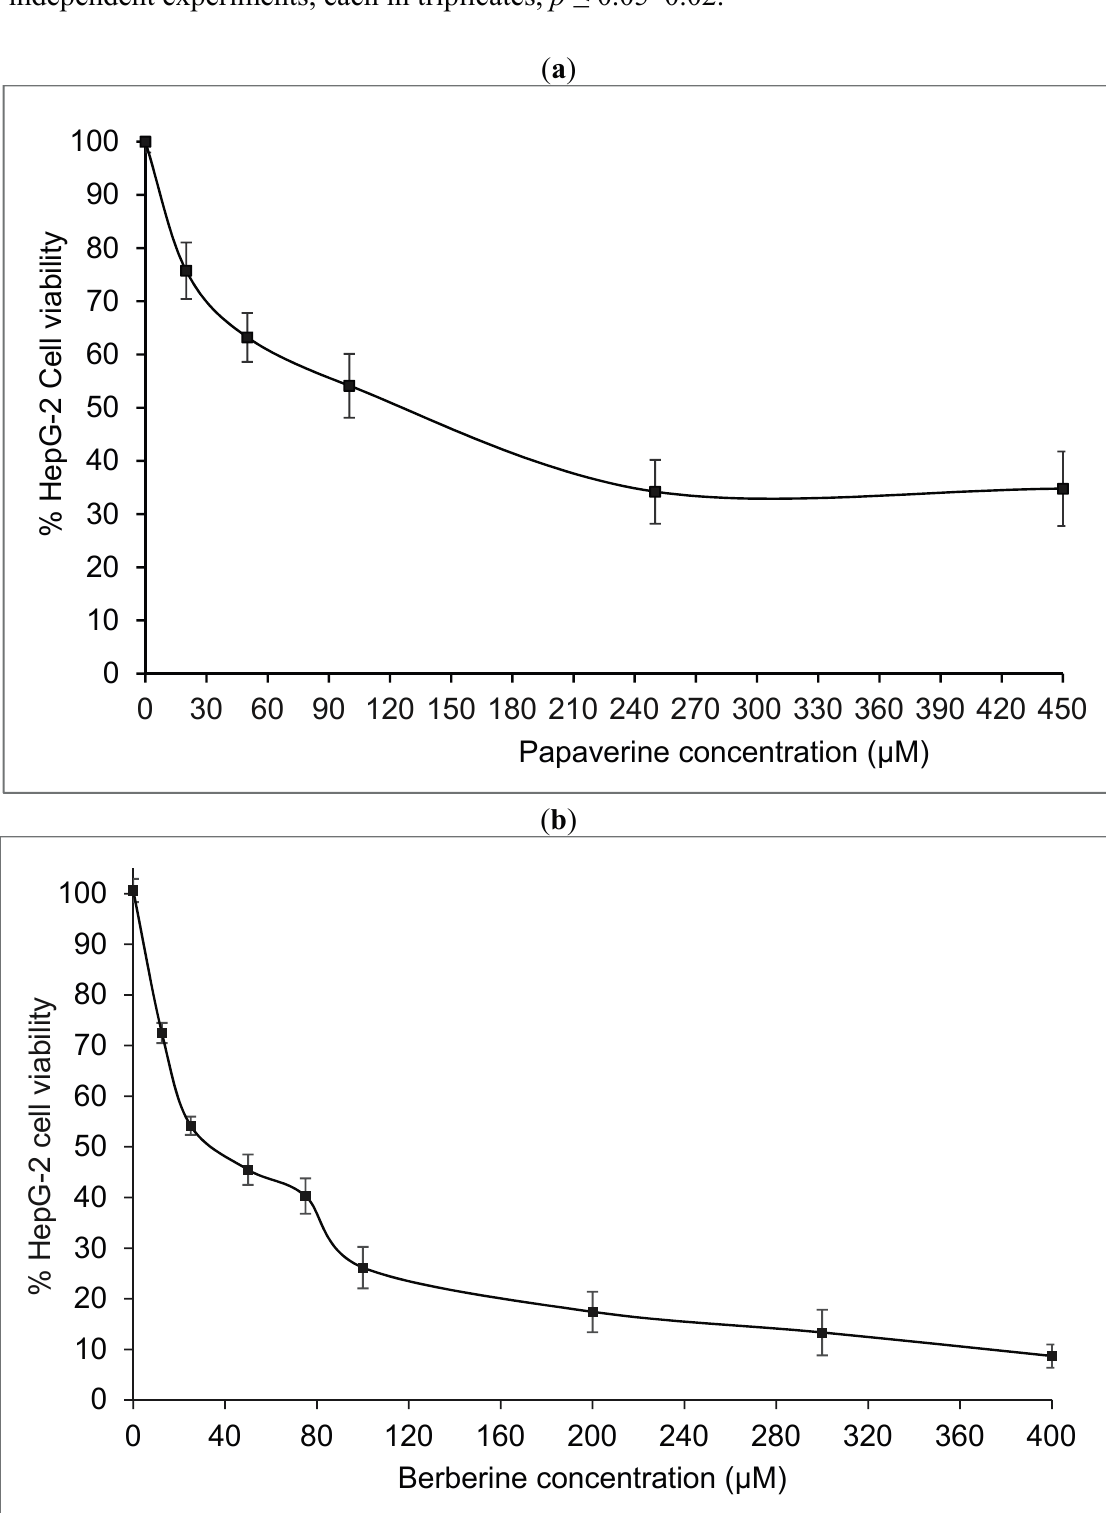
Figure 3. Cell viability after 48 h treatment of HepG2 cells with different concentrations of papaverine ( a ) and berberine ( b ). The curves represents mean values ± SD of three independent experiments, each in triplicates, p ≤